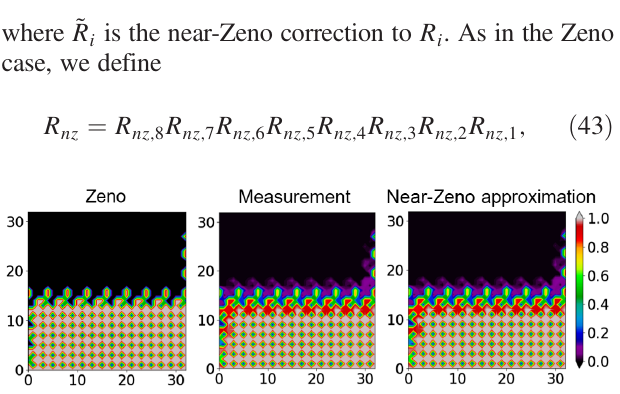
FIG. 11. A comparison of, from left to right, the Zeno limit, the full measurement protocol with 500 measurements per measure- ment step, and the near-Zeno approximation with 500 measure- ments per measurement step — all with ð T= 8 Þ ¼ ð π = 2 Þ . Plotted are the local particle densities for a 33 × 33 site Lieb lattice after 51 measurement steps for the lower half filled plane setup given in Fig.